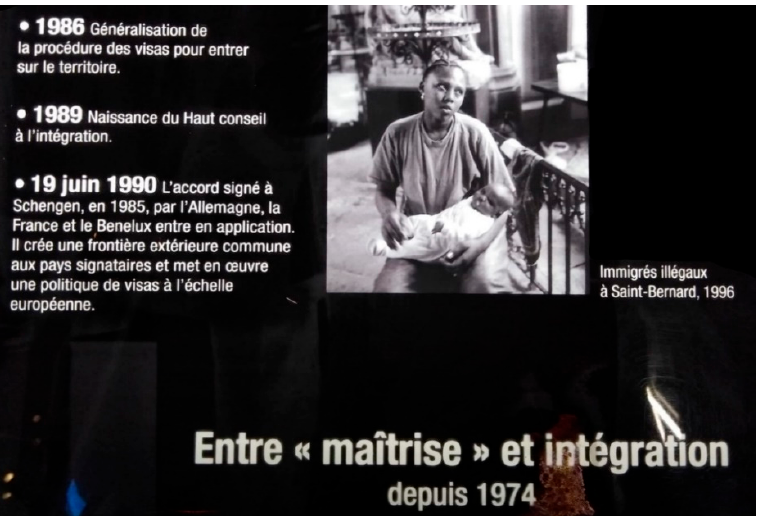
Figure 1. Since the 1980s, the policy of European countries towards migration has focused on two main objectives: to ‘manage’ and reduce the flow of immigrants through border controls, and to ‘integrate’ the migrants already present on the territory by increasing their ‘skills’ (picture taken at the Immigration Museum, Paris, 2020).